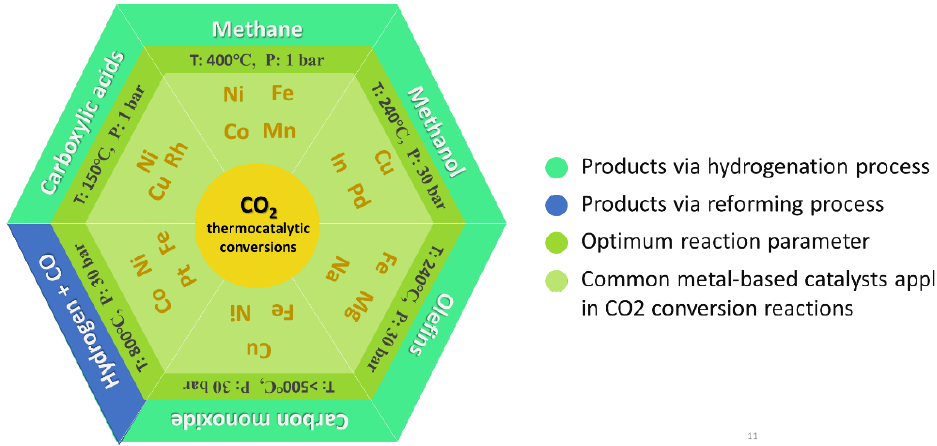
Figure 1. Illustration of CO 2 thermocatalytic conversions into alternative fuels and gasoline via catalytic hydrogenation (denoted in green) and via reforming process (denoted in blue), and the corresponding typical metal-based catalysts that optimize the reaction performances.